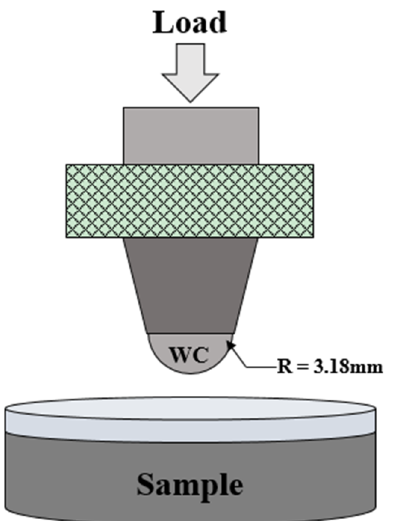
Figure 2. Schematic of a spherical indentation using a WC ball with a radius of 3.18 mm in this study.